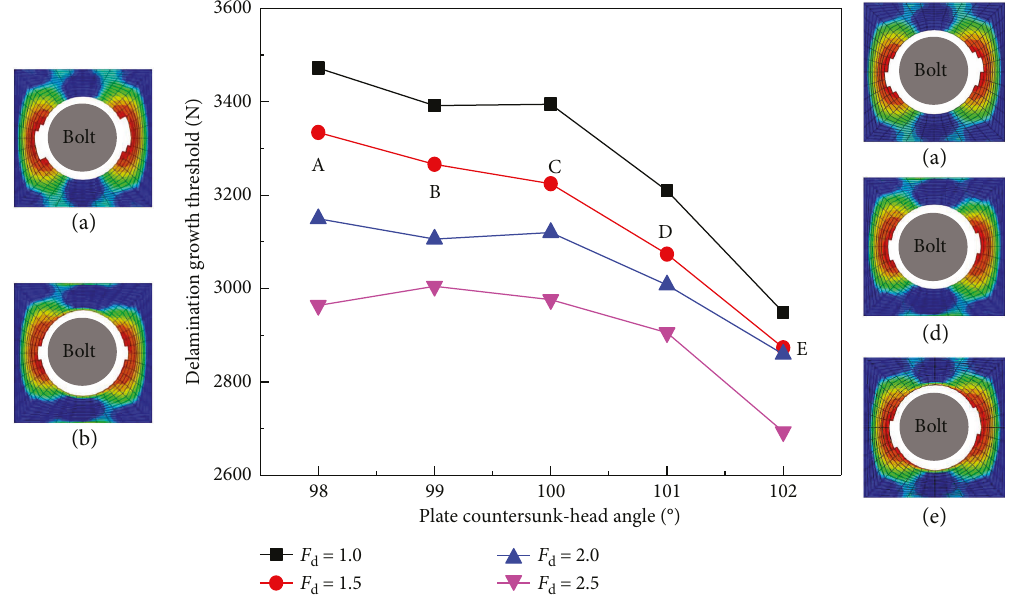
Figure 13: In fl uence of deviation of the countersunk on the delamination evolution under di ff erent delamination